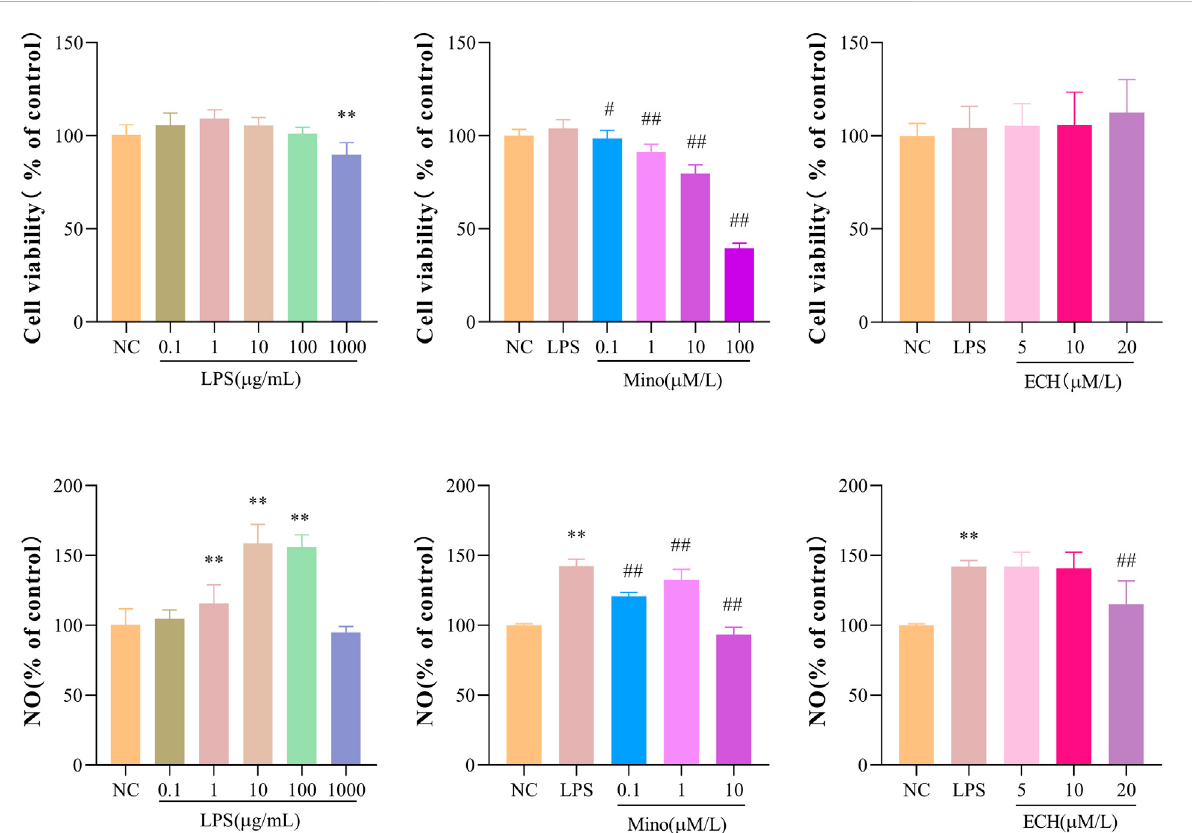
Effects of ECH on Cell Viability and NO Production in LPS induced N9 cells. (A) Cell viability of N9 microglial cells incubated with .1, 1, 10, 100, and 1000 μ g/ml of lipopolysaccharide (LPS) for 24 h; (B) Cell viability of N9 microglial cells stimulated with .1, 1, 10 μ M of minocycline (Mino) and 1 μ g/ml LPS for 24 h; (C) Cell viability of N9 microglial cells treated with 5, 10, and 20 μ M of ECH and 1 μ g/ml LPS for 24 h. (D) NO production of N9 microglial cells incubated with .1, 1, 10, 100, and 1000 μ g/ml of LPS for 24 h; (E) NO production of N9 microglial cells stimulated with .1, 1, 10 μ M of Mino and 1 μ g/ml LPS for 24 h; (F) NO production of N9 microglial cells treated with 5, 10, and 20 μ M of ECH and 1 μ g/ml LPS for 24 h. Results are expressed as percentage values, taking control group as 100%. n = 6/group. ** p < .01 compared with control group; # p < .05, ## p < .01 compared with LPS